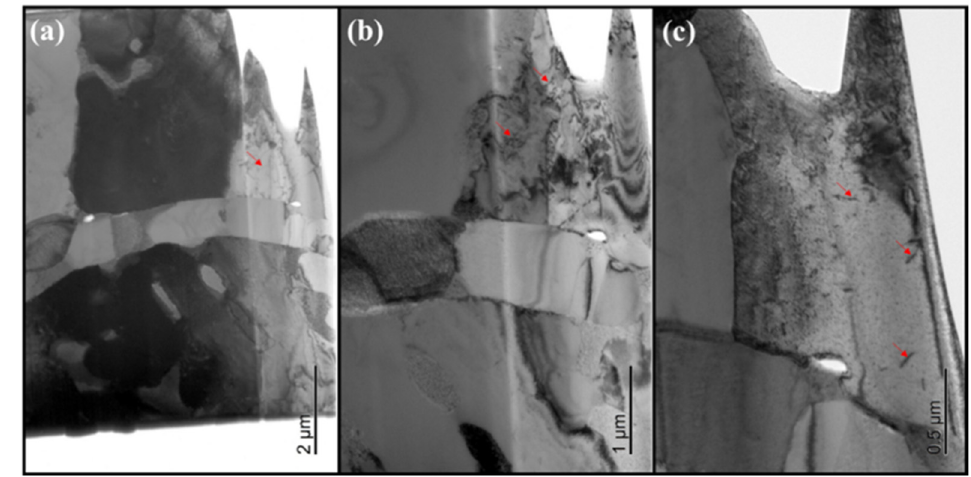
Figure 9. ( a – c ) TEM morphology of 4# high entropy alloy powder. The red arrows indicated the dislocation lines.